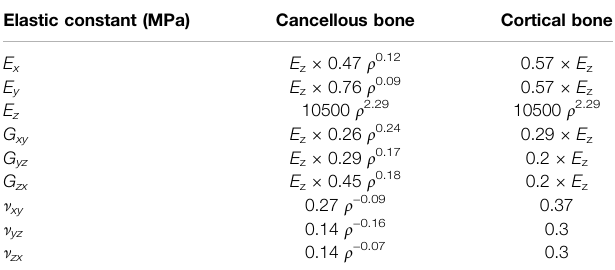
elastic constants as functions of element ash density ρ ash (g/cm 3 ) (Enns-Bray et al.,